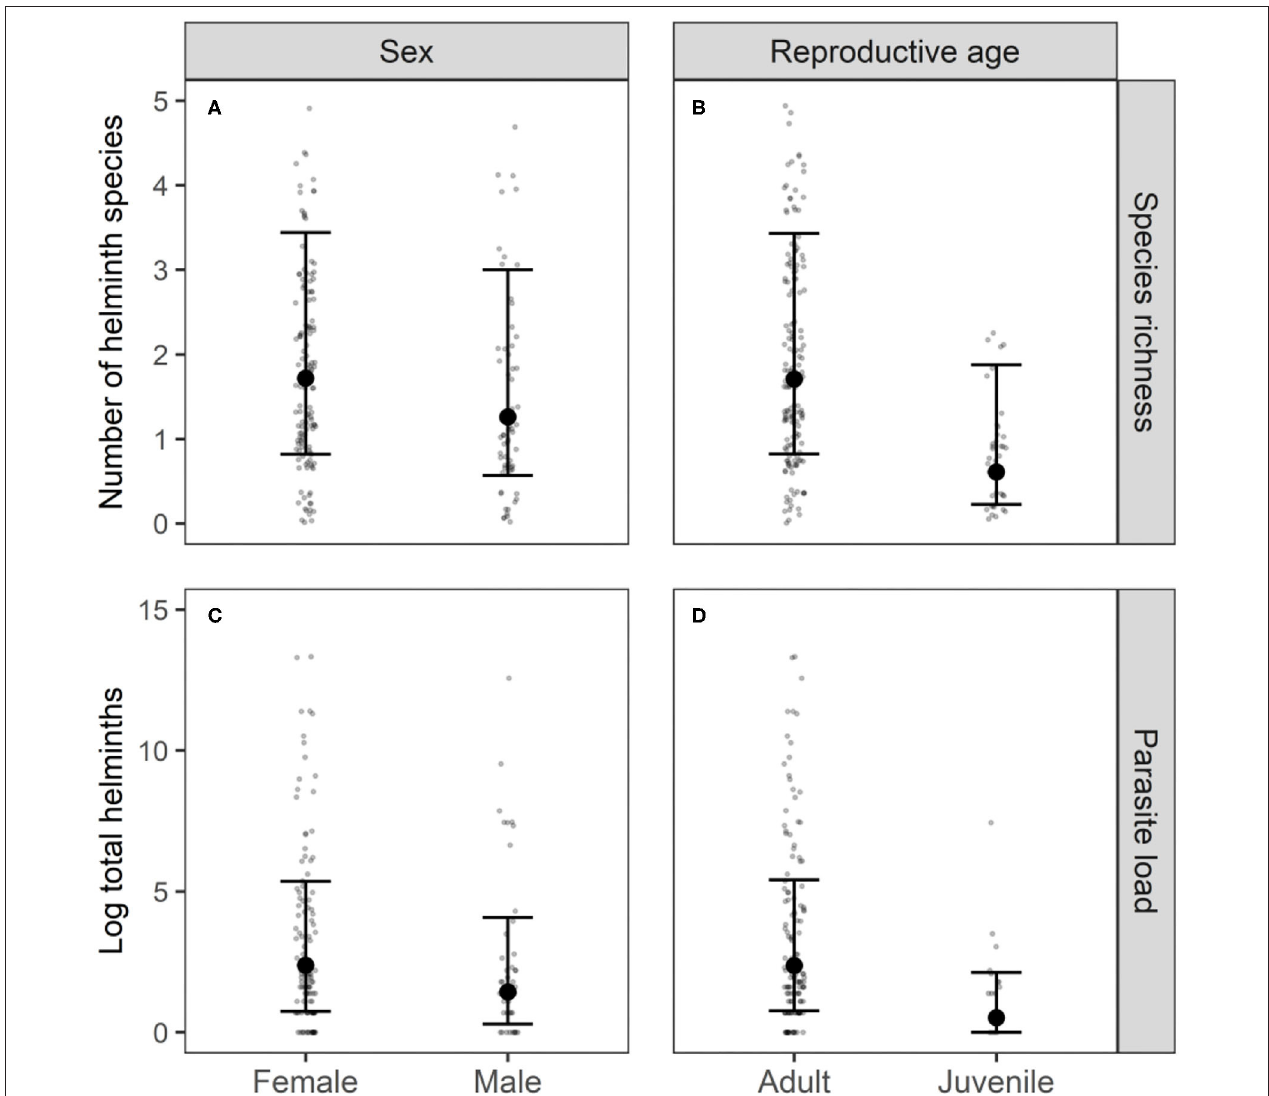
FIGURE 2 | Differences in species richness and log-transformed parasite load between sexes (A,C) and reproductive age groups (B,D) . Black dots and error bars are, respectively, the predicted means and 95% credible intervals derived from the presence-absence model (A,B) and abundance COP model (C,D) . Gray dots are the observations per